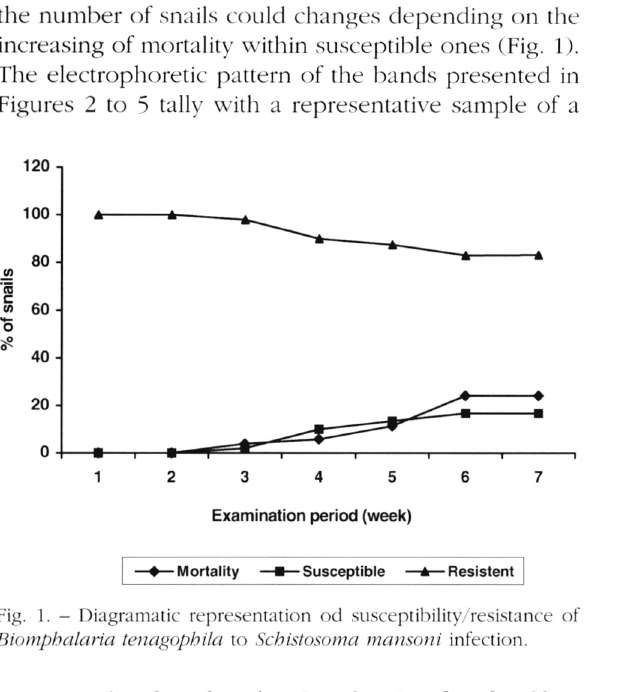
Fig. 1. - Diagramatic representation od susceptibility/resistance of Biomphalaria tenagophila to Schistosoma mansoni infection.